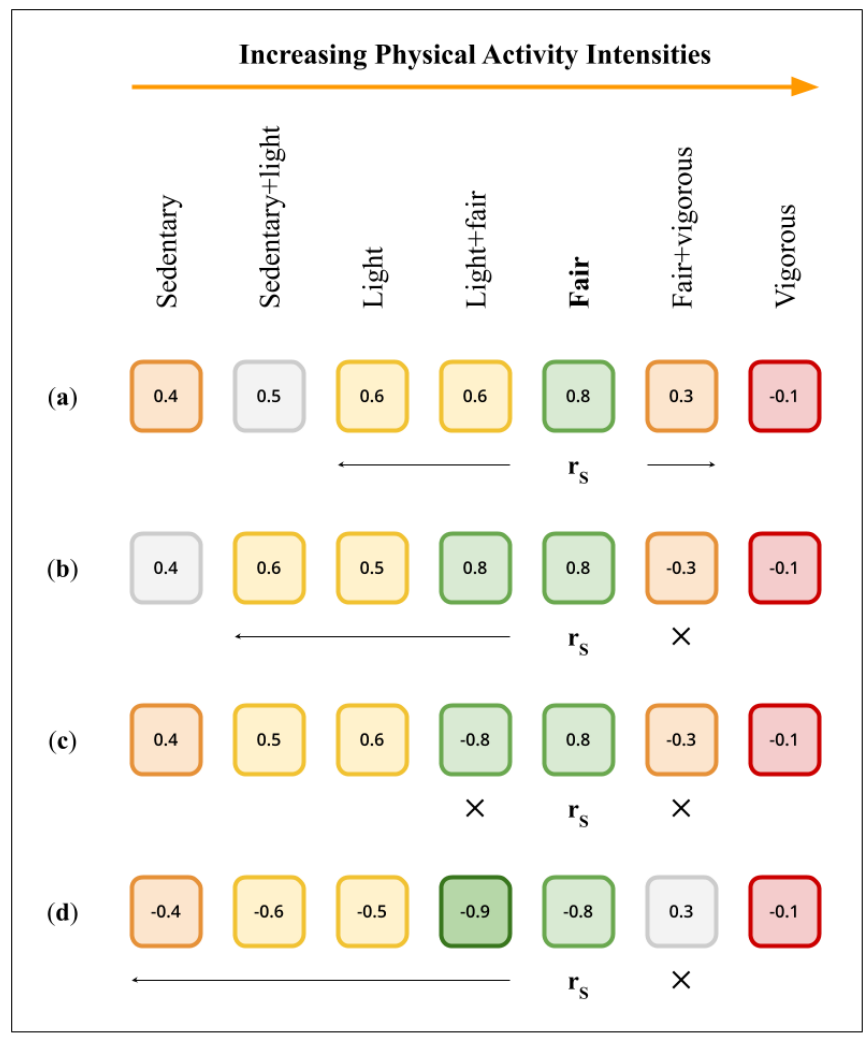
Figure A2. Examples of contours of correlations interrupted by non-significant or opposite-sign correlations. r S marks the target correlation. marks an interruption. Arrows mark the width of the × contour. Only significant correlations are colored from red (weak) to green (strong). In example ( a ), the contour is interrupted by a non-significant correlation (at a lower intensity) and an opposite-sign correlation (at a higher intensity). Example ( b ) interrupts the entire right side of the contour by an opposite-sign correlation, represented with . Example ( c ) depicts a singleton contour, marked with × × on both sides. Example ( d ) illustrates the rare case of a higher correlation than the target correlation, both in the same